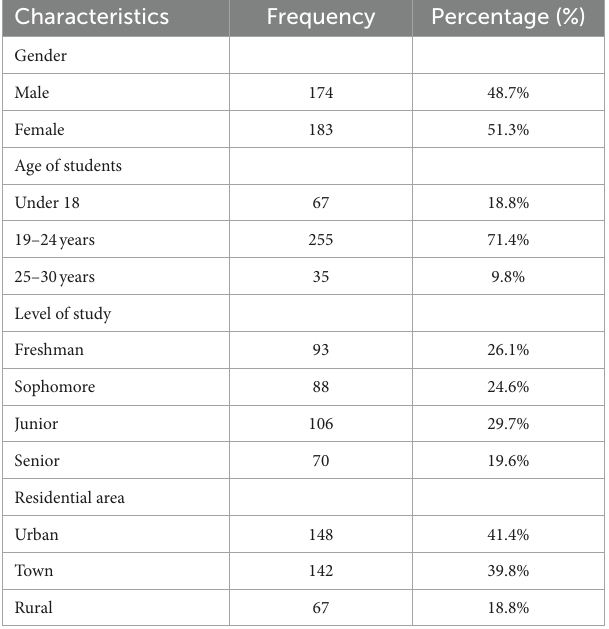
TABLE 1 Demographic characteristics of students.